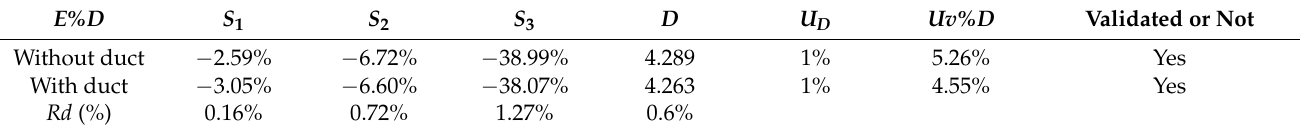
Table 3. Validation result for JBC hull without/with the original duct.